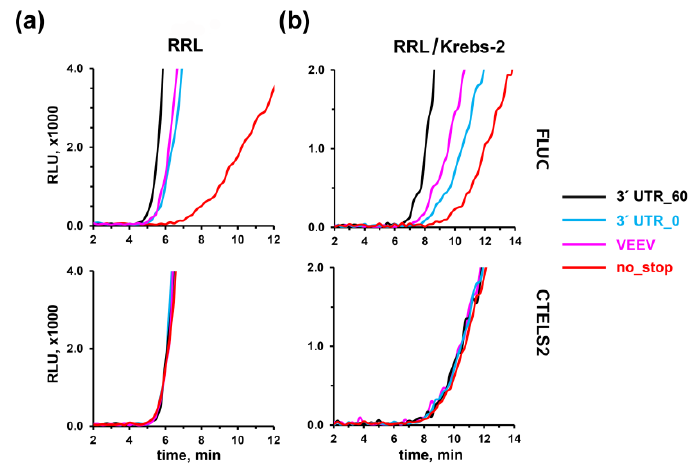
Figure 4. Effects of read-through inducing sequence on translation termination rate. A pair of reporter mRNAs (FLUC and CTELS2) bearing at the 3 ′ end either a 3 ′ UTR with the artificial sequence (agcatc) 10 (3 ′ UTR_60), the structure derived from the VEEV 3 ′ UTR, or no 3 ′ UTR at all (3 ′ UTR_0), as well as the nonstop mRNA, were translated in RRL ( a ), or the hybrid RRL/Krebs-2 ( b ) cell-free systems. Representative curves of at least three independent experiments are shown.